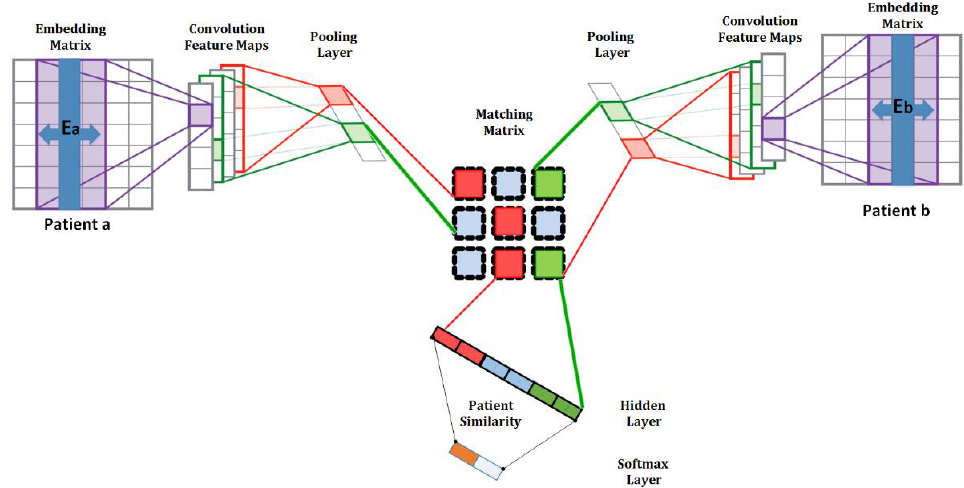
Figure 1. Supervised patient similarity matching framework.